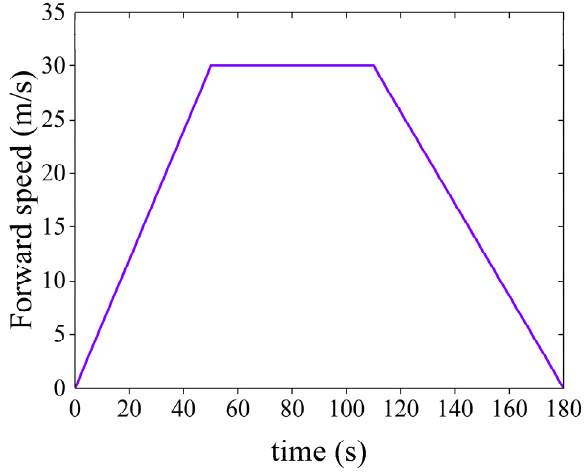
Figure 3. The forward speed of the helicopter in simulation.